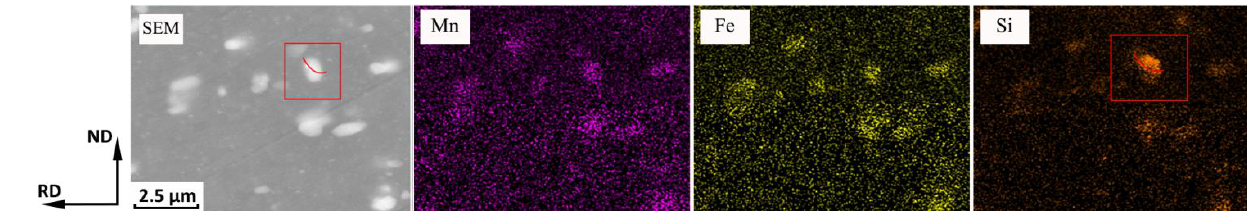
Figure 4. EDS mappings for the dispersoids in sample B.